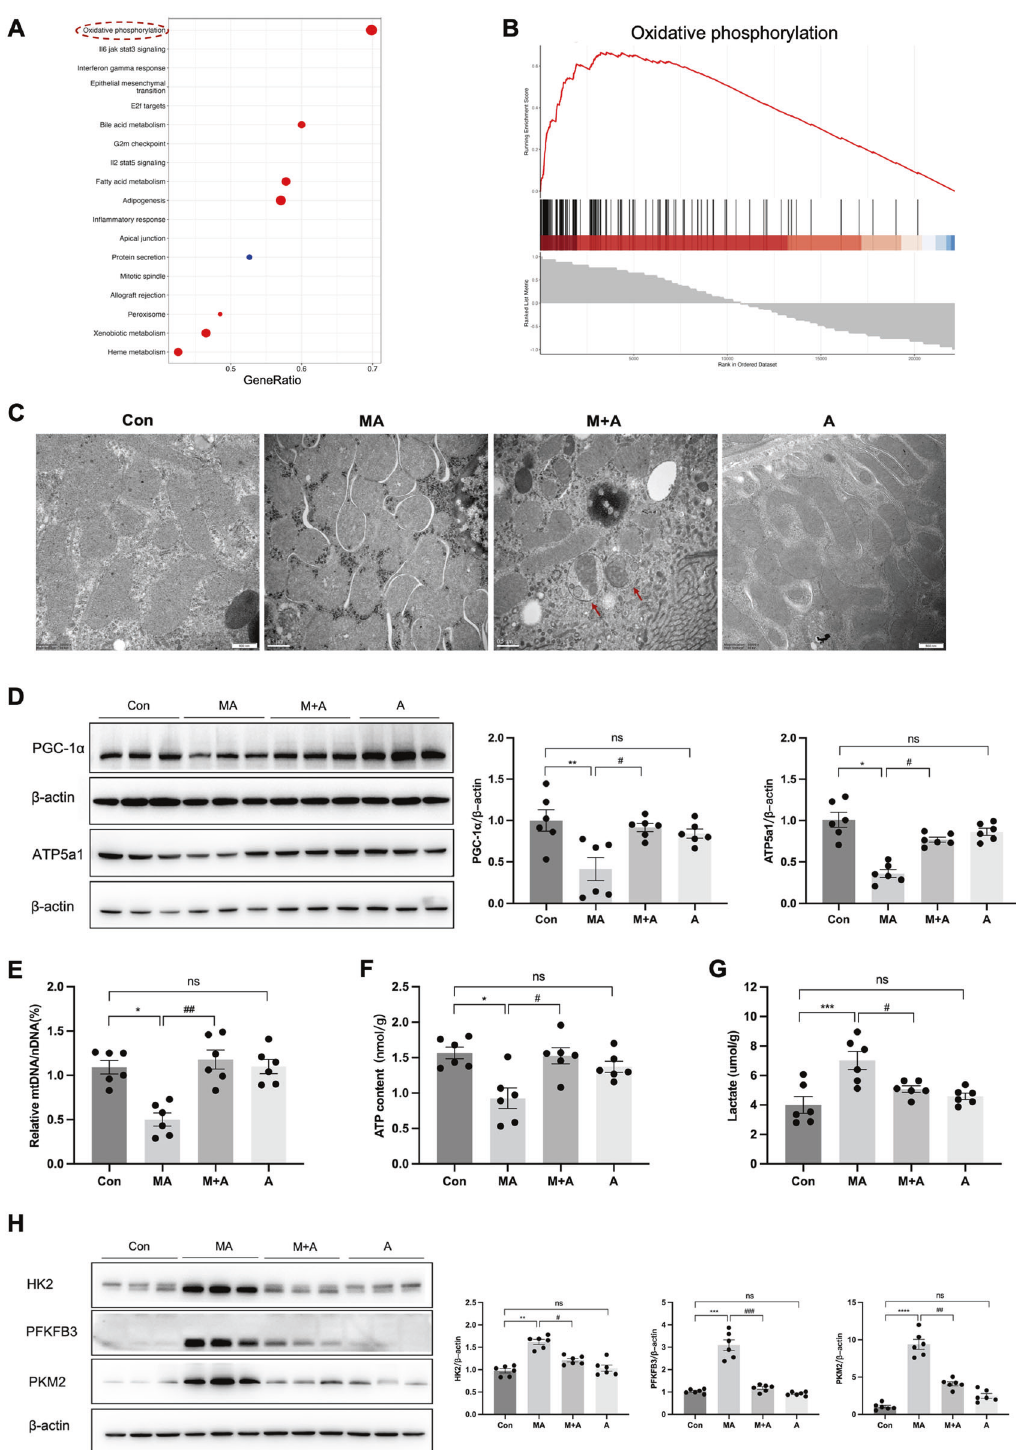
Fig. 4 ALDH2 activation restored mitochondrial homoeostasis and suppressed aerobic glycolysis in MA-induced AKI. A Gene set enrichment analysis (GSEA) analysis for differentially expressed genes (DEGs) between MA and M + A groups. B GSEA analysis of the oxidative phosphorylation pathway. C Representative transmission electron microscopy (TEM) micrographs of mouse renal tubular epithelial cell mitochondria in each group. The red arrow showed autophagosomes. Scale bars, 0.5 μ m. D The expression of mitochondria-related proteins (PGC-1 α and ATP5a1) was measured by western blotting ( n = 6). E mtDNAcontent was assessed by quantitative RT-PCR expressed as the ratio of the mitochondrial genome to the nuclear genome ( n = 6). F ATP levels were assessed using an ATP Assay Kit ( n = 6). G The lactate (the fi nal product of aerobic glycolysis) content was measured in 4 groups ( n = 6). H The expression of aerobic glycolysis-related enzymes (HK2, PFKFB3 and PKM2) was measured by western blotting ( n = 6). * P <0.05, ** P <0.01, *** P <0.001, **** P < 0.0001; # P <0.05, ## P <0.01, ### P <0.001, #### P <0.0001; ns not signi fi cant. (Con Control, MA maleic acid, M + A maleic acid + Alda-1, A Alda-1, mtDNA mitochondrial DNA, nDNA nuclear DNA).